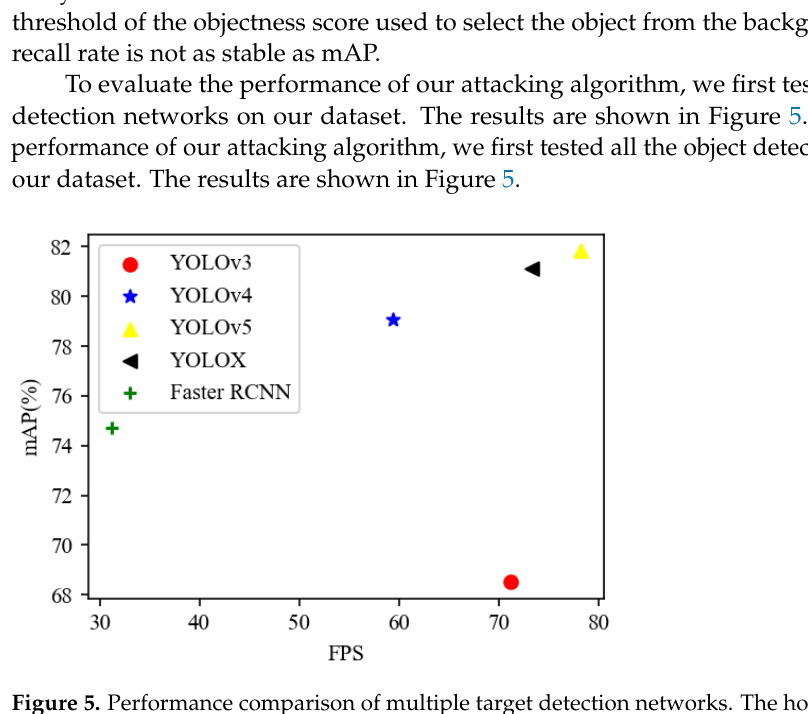
Table 1. Testing result of the scale adaptiveness.